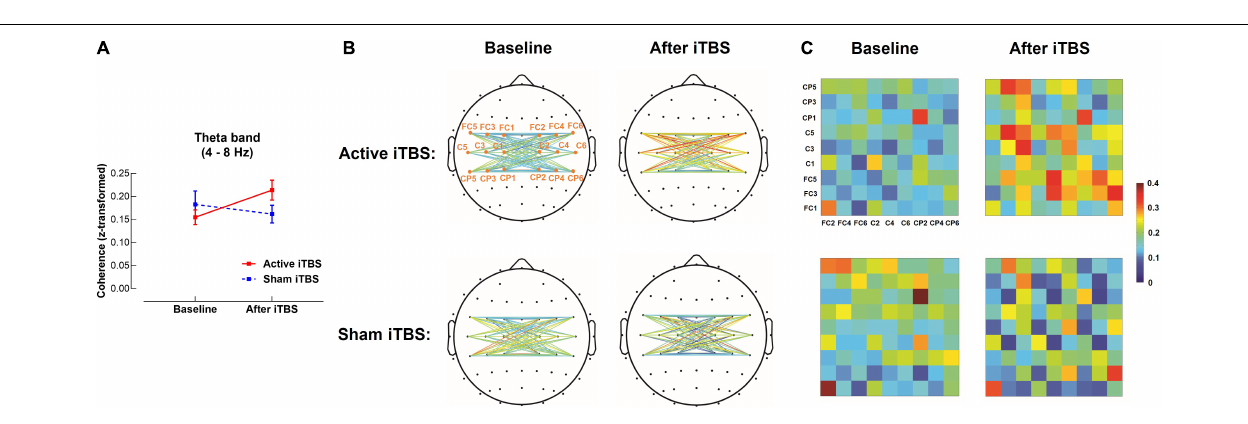
FIGURE 2 | Theta band interhemispheric functional connectivity change after iTBS. Theta band coherence between left and right sensorimotor cortices was significantly increased in the Active iTBS group, but not in the Sham iTBS group after iTBS (A) . The topographies (B) and matrixes (C) represent z-scores of coherences between pairs of electrodes in the left and right sensorimotor cortices before and after iTBS in the Active and Sham iTBS groups. Warmer colors indicate greater coherence, while cooler colors indicate less